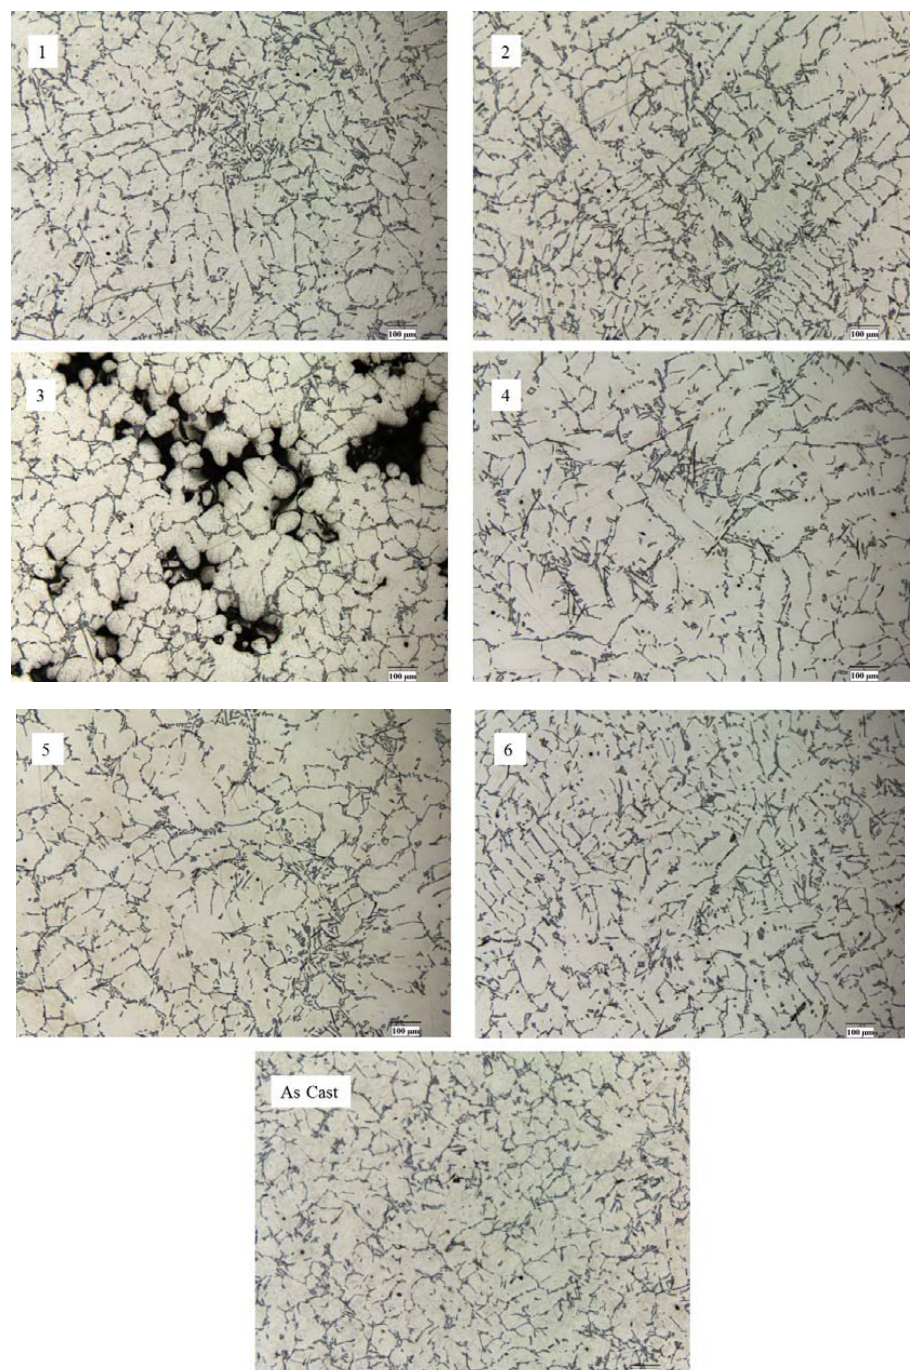
Figure 7. Optical microstructures of 356 alloy: 1—after vibration by 100 Hz; 2—after vibration by 150 Hz; 3—after vibration by 200 Hz; 4—after modification by ultrafine powder modifier; 5—after modification by ultrafine powder modifier followed by 100 Hz vibration; 6—after modification by ultrafine powder modifier followed by 150 Hz vibration; As cast—unmodified and untreated alloy.